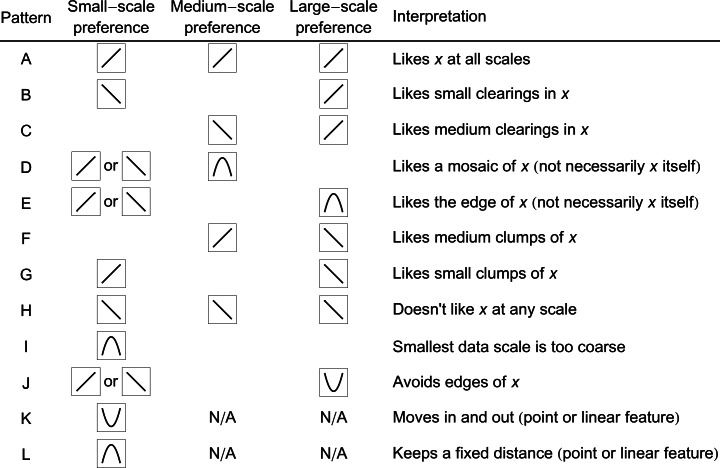
Possible interpretations of certain combinations of selection functions at small, medium, and large scales.Small-scale refers to smoothing <5 pixels, medium-scale refers to smoothing up to the choice radius (10 pixels), and large-scale refers to smoothing greater than the choice radius. Point and linear features are coded as ‘distance to …’ arrays, which are intrinsically smooth at scales up to the typical distance between features, and so are analysed without further smoothing.